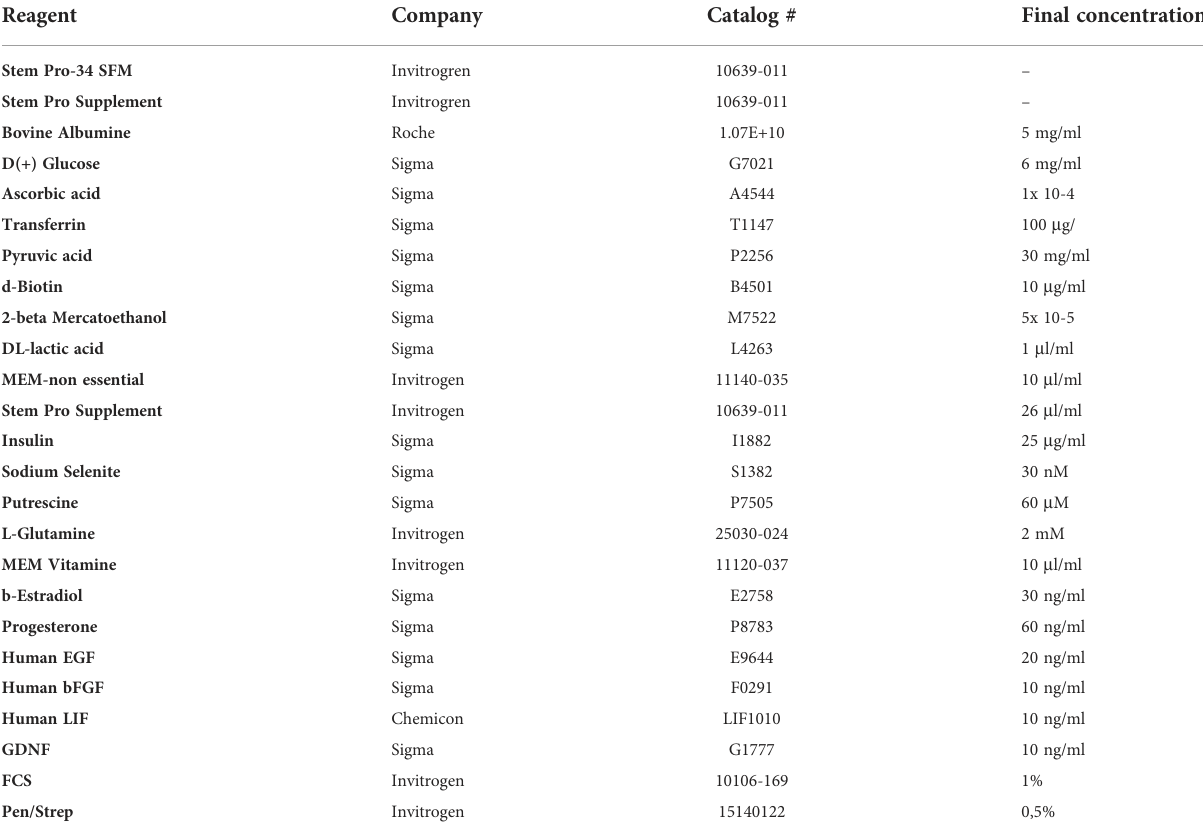
TABLE 1 Stempro Complete culture media